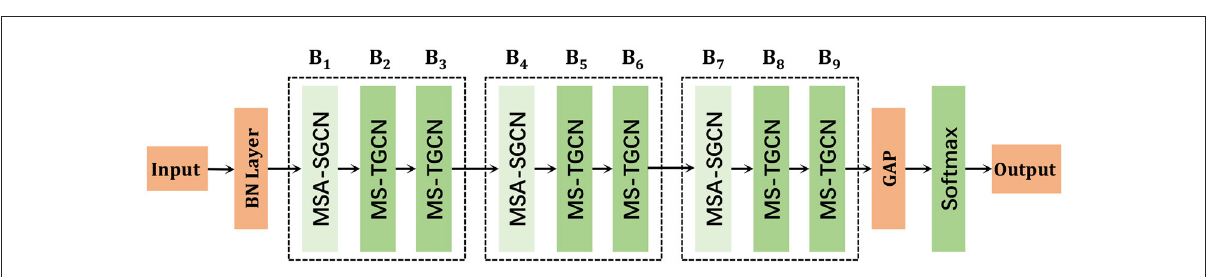
FIGURE2 Multi-scale attention spatiotemporal graph convolution network.